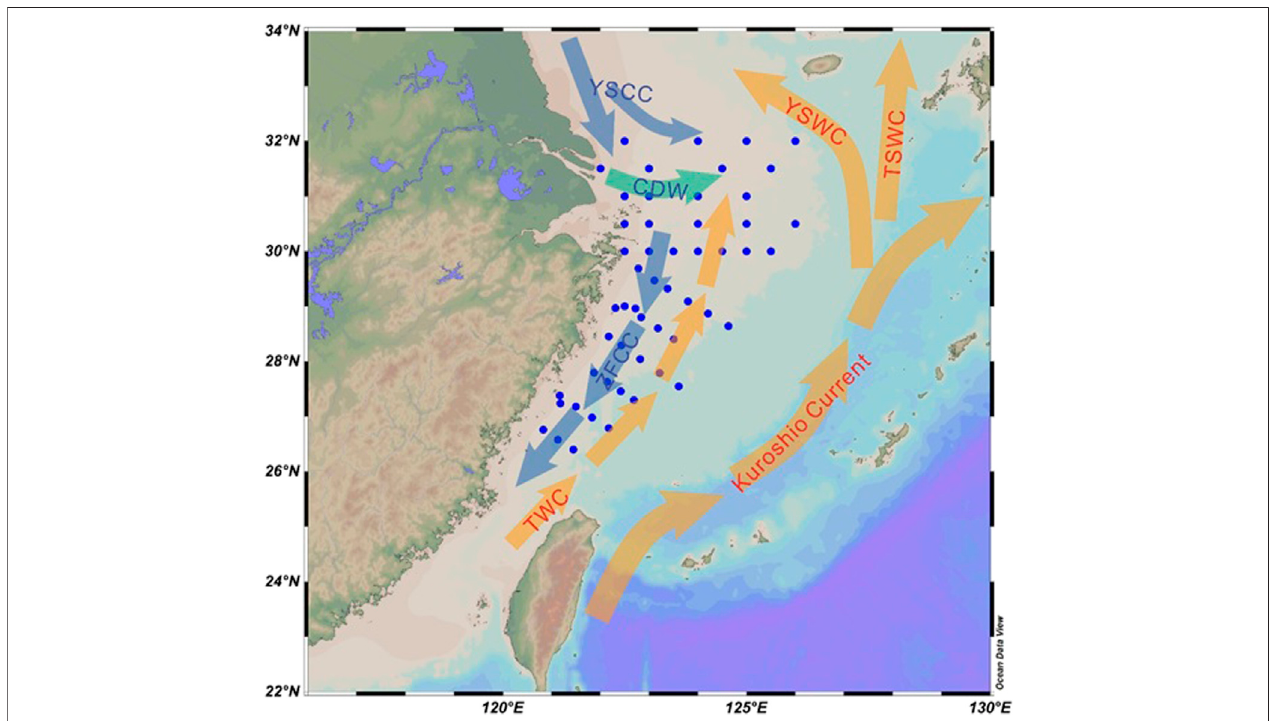
FIGURE 1 | Location of surface sediment samples in the East China Sea. ZFCC: Zhejiang and Fujian Coastal Current; TWC: Taiwan Warm Current; YSCC: Yellow Sea Coastal Current; YSWC: Yellow Sea Warm Current; TSWC: Tsushima Warm Current; CDW: Changjiang diluted water.